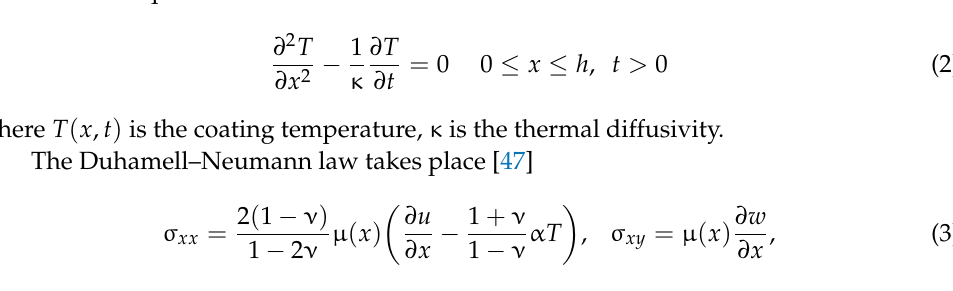
where σ xx ( x , t ) , σ xy ( x , t ) are the normal and shear components of the stresses in the coating.